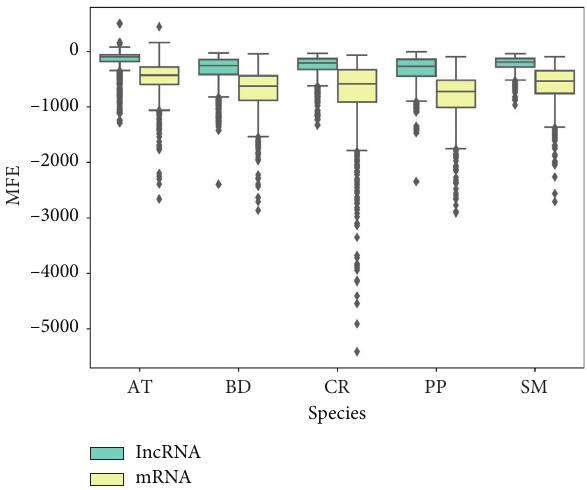
Figure 3: Boxplots of MFE. Green indicated the MFE dispersion of lncRNAs, and yellow indicated the MFE dispersion of mRNAs. Compared with protein-coding transcripts, lncRNAs had higher